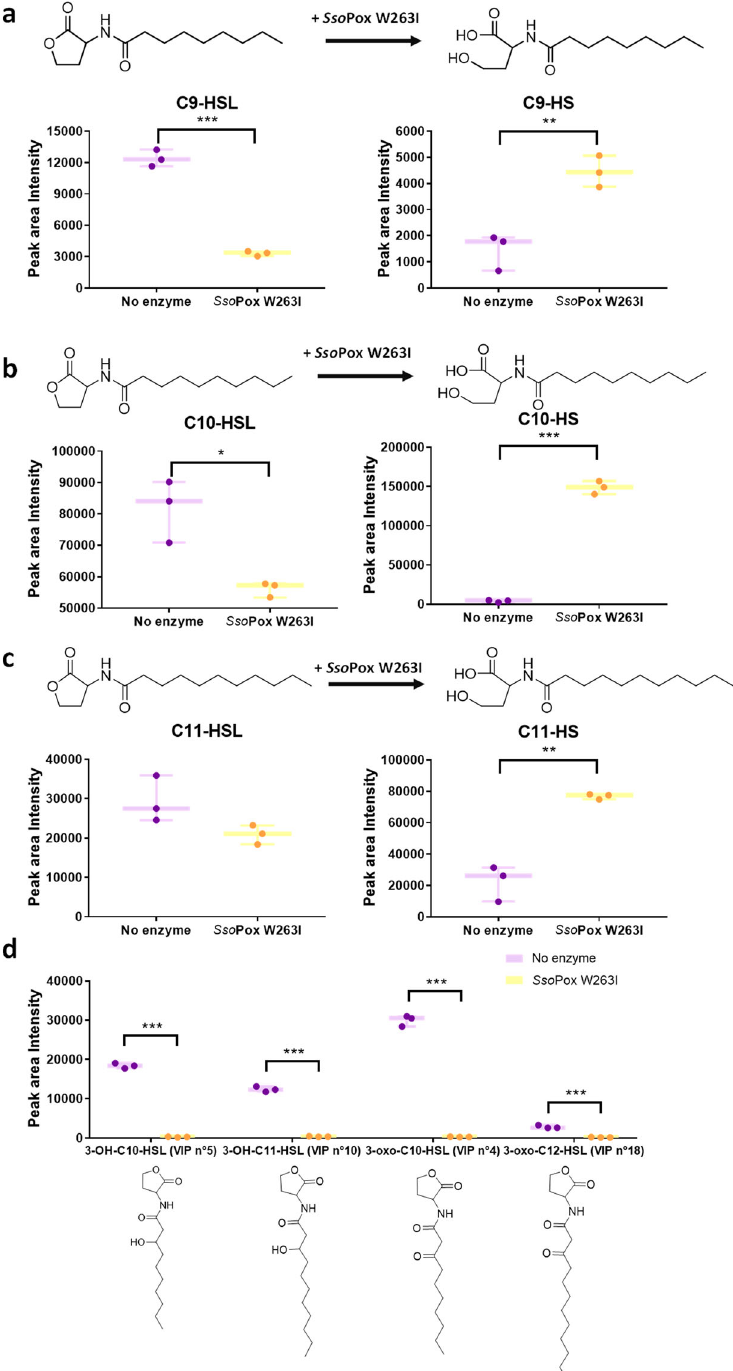
Fig. 4 Sso Pox W263I impacts production of AHLs in CV 12472. Chemical structures and LC-MS peak area intensities of AHLs and their hydrolyzed form in control (purple) and treated samples (yellow). a C9-HSL, b C10-HSL, c C11-HSL, and d other AHLs. Bars represent the mean and standard deviations of peak area intensities on the corresponding LC-MS chromatograms in three biological replicates (each represented by one point). * P value <0.05, ** P value <0.01, *** P value <0.001 according to Student ’ s t form N -dodecanoyl-homoserine (C12-HS) was detected. Super- and identi fi cation of AHLs reported to our knowledge, for the fi rst natant extracts obtained after removal of bacterial cells by time in CV 12472: N -nonanoyl-homoserine lactone (C9-HSL), centrifugation were also analyzed by LC-MS and allowed the N -undecanoyl-homoserine lactone (C11-HSL), N -(3-oxodecanoyl)- detection of the same AHLs in the same proportions as those homoserine lactone (3-oxo-C10-HSL), N -(3-hydroxyundecanoyl)- observed in the whole-culture extracts (Supplementary Fig. 1a). homoserine lactone (3-OH-C11-HSL), and N -(3-oxododecanoyl)- The detection of diverse AHLs in CV 12472, albeit reported for homoserine lactone (3-oxo-C12-HSL). In addition, while N -dode- the fi rst time, is comparable to many bacterial species known to canoyl-homoserine lactone (C12-HSL) was not observed, its open